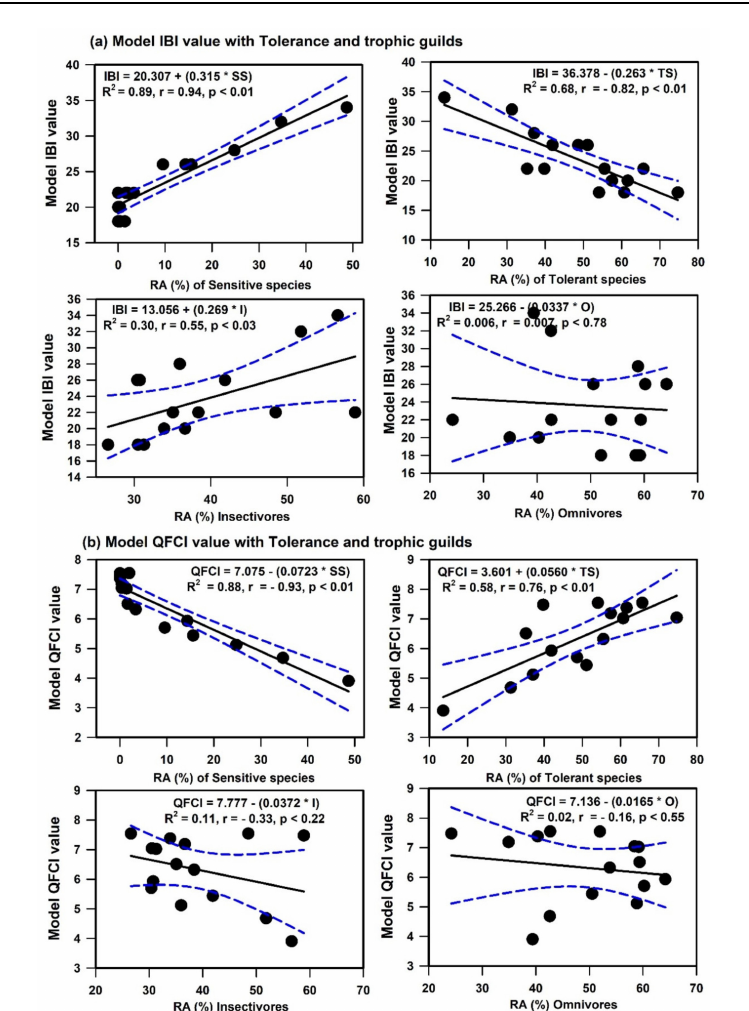
Figure 6. Relations among the Index of Biotic Integrity (IBI) and Quantitative Fish Community Index (QFCI) model values with tolerant and trophic